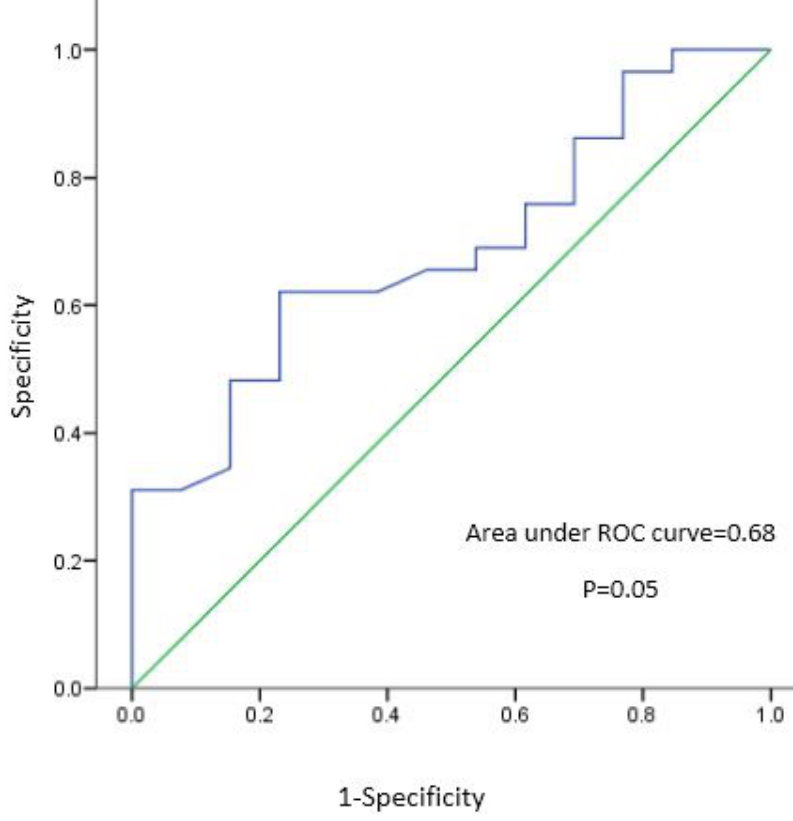
Figure 1. Receiver-operating characteristic (ROC) curve and corresponding area under the curve (AUC) statistics for probability of detection recall rate < 3 vs median urinary iodine cut-offs.